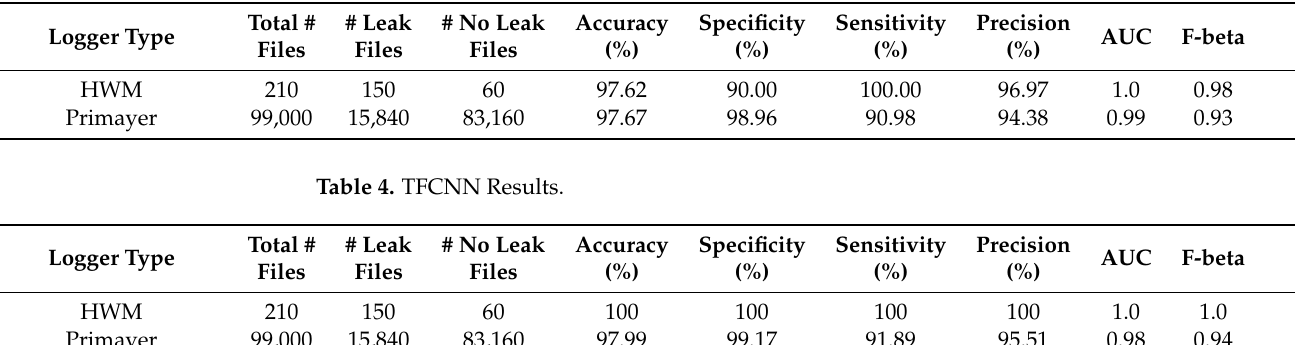
Table 3. FCNN Results.